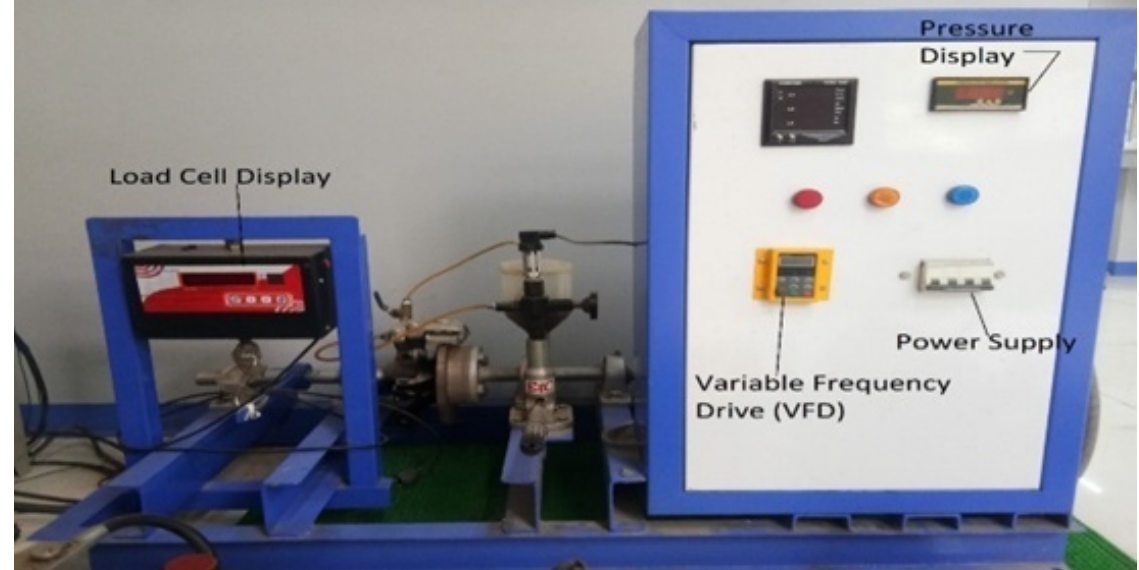
Figure 10. Novel Test